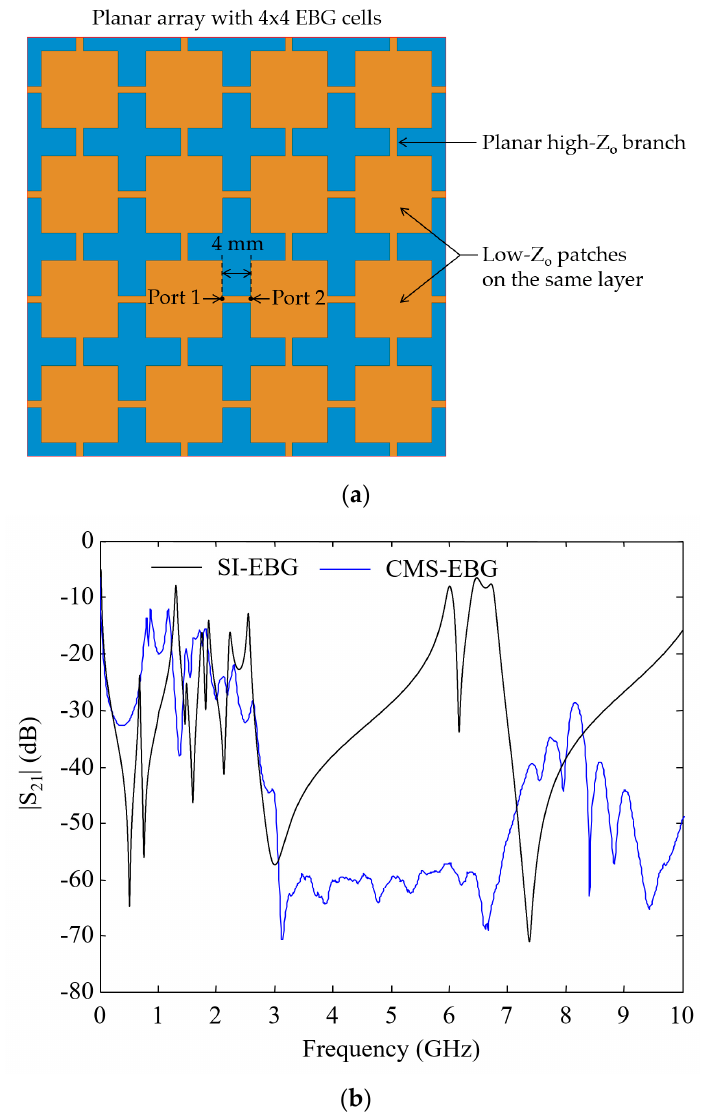
Figure 11. ( a ) Finite-element method (FEM) simulation model of the previous stepped-impedance EBG (SI-EBG) structure and ( b ) comparison of the noise suppression characteristics between CMS-EBG and the SI-EBG structures.